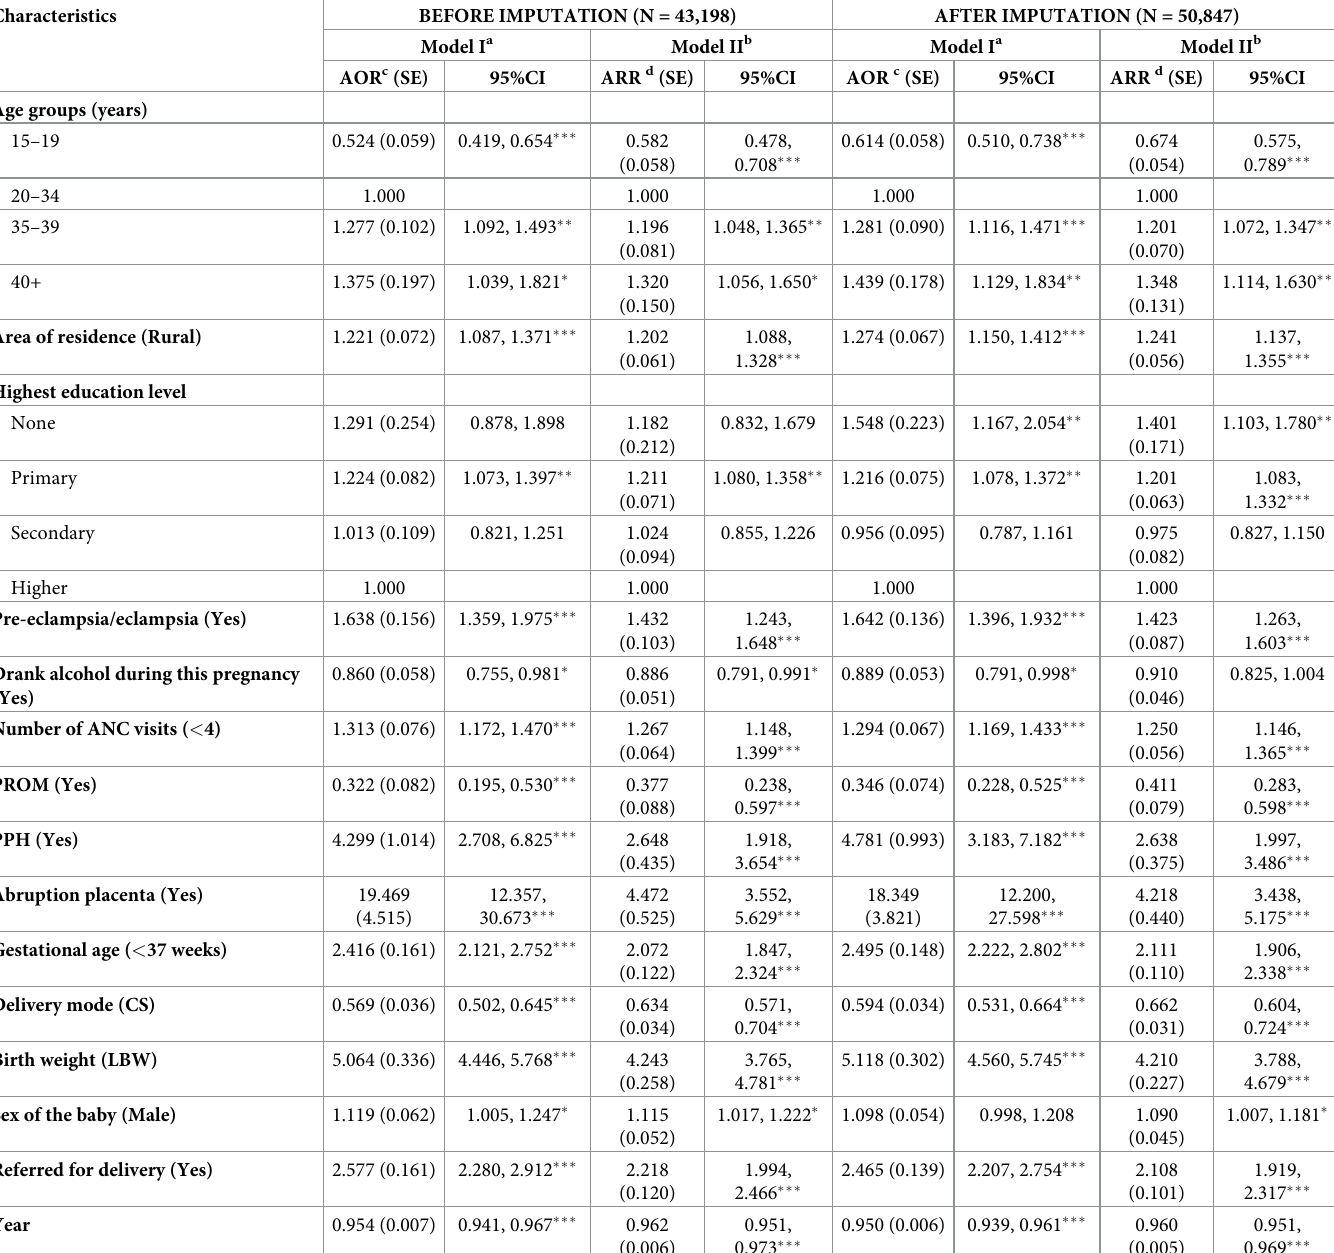
Table 5. Adjusted analysis showing predictors of perinatal death.